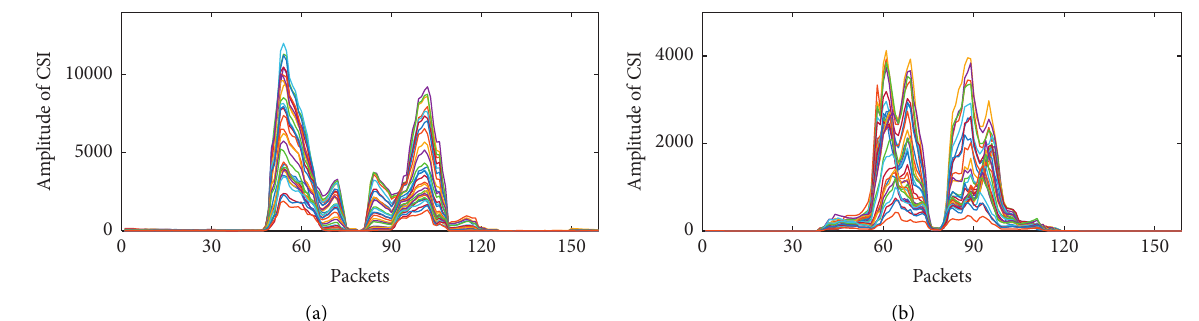
Figure 8: Enhanced signal based on PSE. (a) First antenna; (b) second